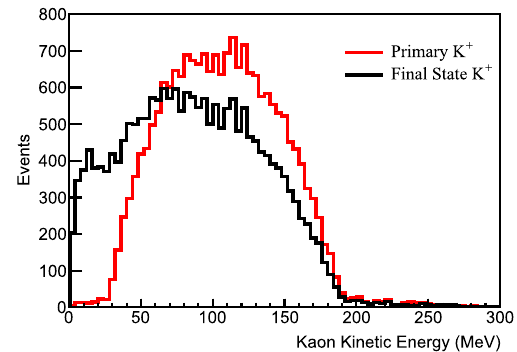
Fig. 28 Kinetic energy of kaons in simulated proton decay events, p → K + ν , in DUNE. The kinetic energy distribution is shown before and after final state interactions in the argon nucleus